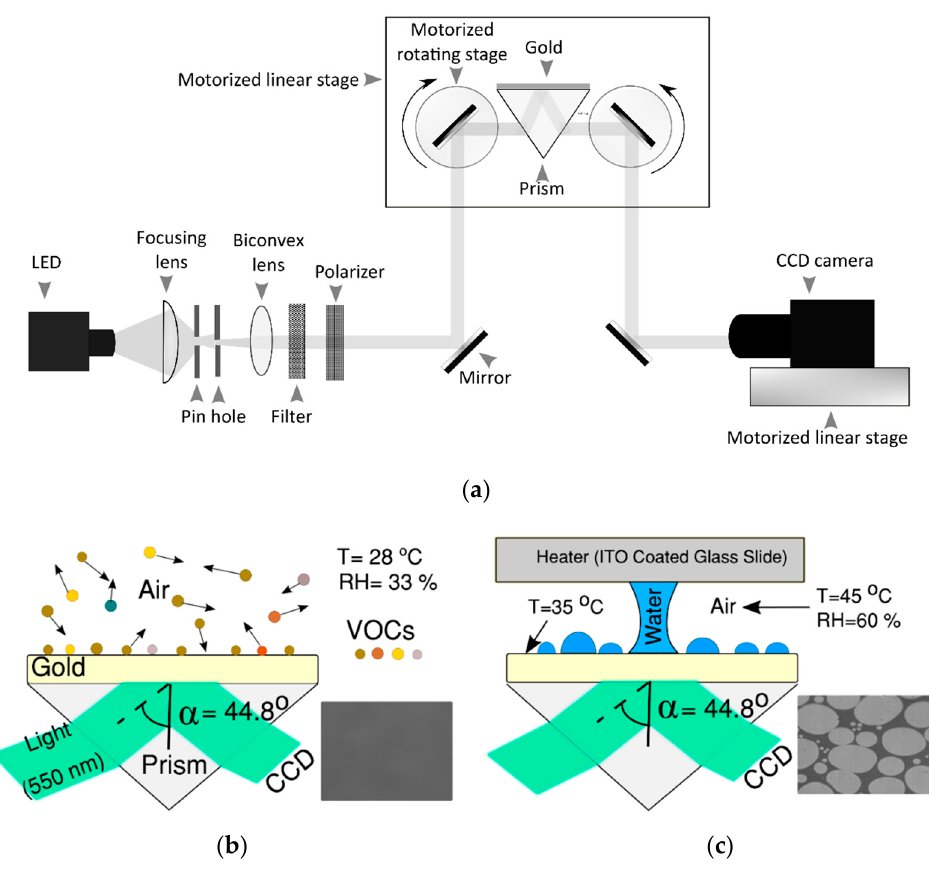
Figure 1. ( a ) Schematic of the automated surface plasmon resonance imaging (SPRi) instrument (a p-polarized monochromatic (550 nm) collimated light was used for SPRi), ( b ) schematic of volatile organic compound (VOC) adsorption experiment using SPRi, and ( c ) experimental conditions for SPRi of dropwise condensation (brighter color represents droplets and darker color represents the gold substrate).